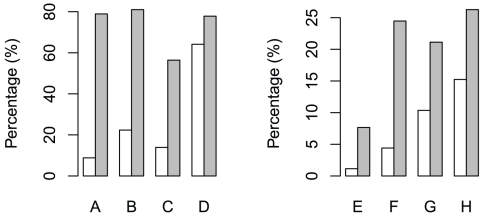
Percentages of sleepers who (A) have difficulty falling asleep, (B) wake up during the night and not be able to fall back asleep, (C) wake up too early in the morning, (D) have irregular sleeping time, (E) have received sleep treatment, (F) have taken sleeping medicine, (G) have the symptoms of restless legs syndrome, and (H) have experienced periodic limb movements during sleep.White bars represent the normal and gray the insomniac group.